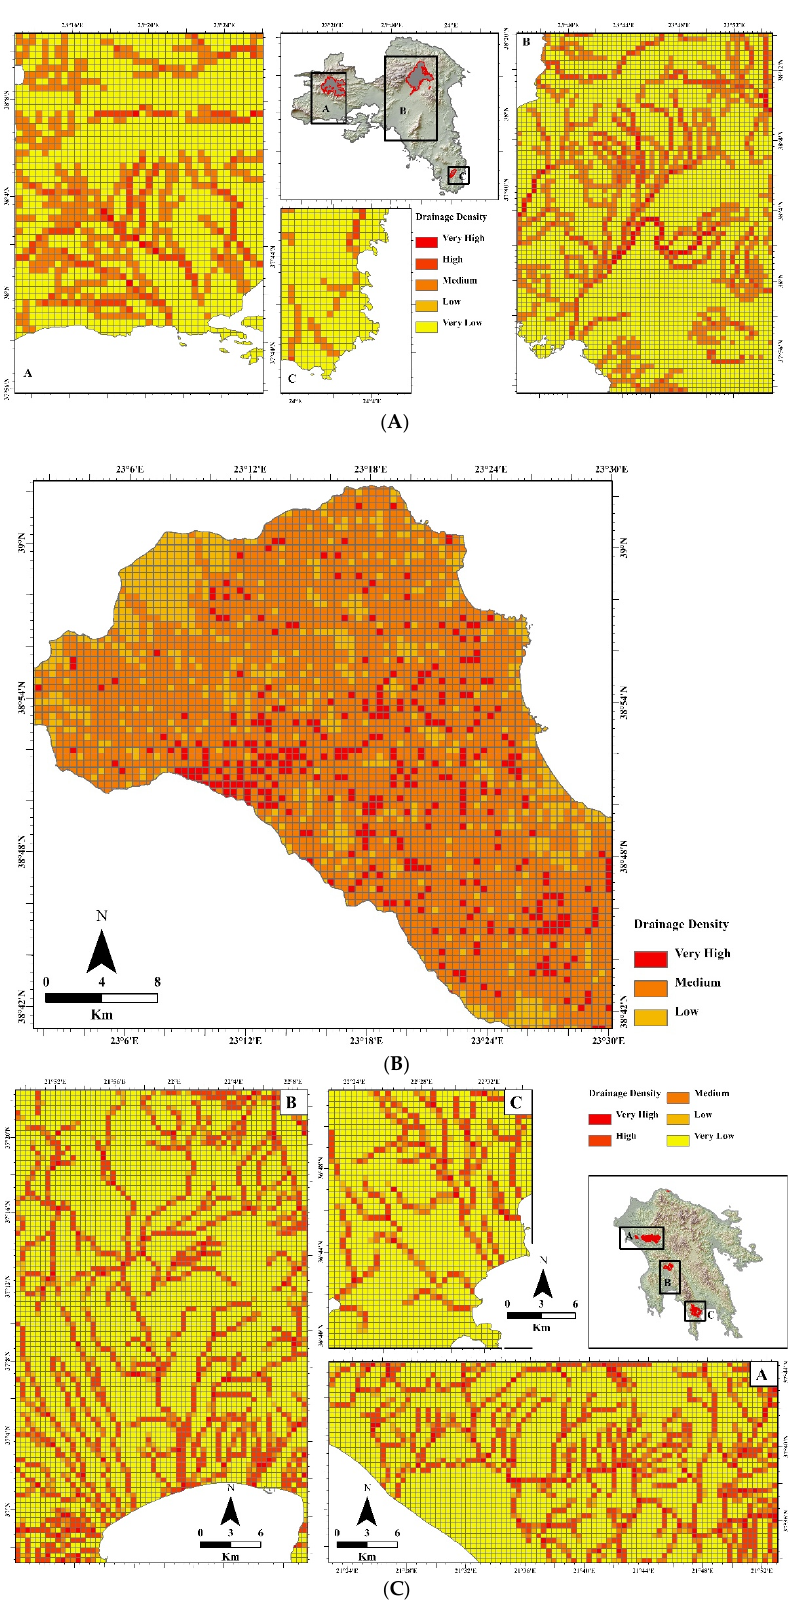
Figure 8. Classification of slope into five values: ( A ) Attica, ( B ) Euboea, and ( C ) Peloponnese.